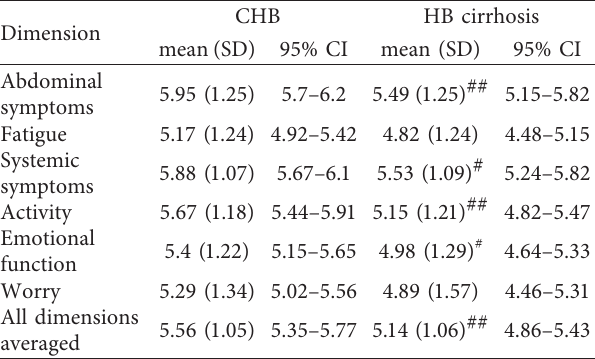
Figure 2: Comparison of EQ-5D VAS scores between study groups. The HB cirrhosis groups had significantly ( ∗∗ p < 0 . 01) lower VAS scores than the HC group and significantly ( ∗ p < 0 . 05) lower VAS scores than the CHB group. Table 4: Comparison of CLDQ dimension and total scores between HB groups.